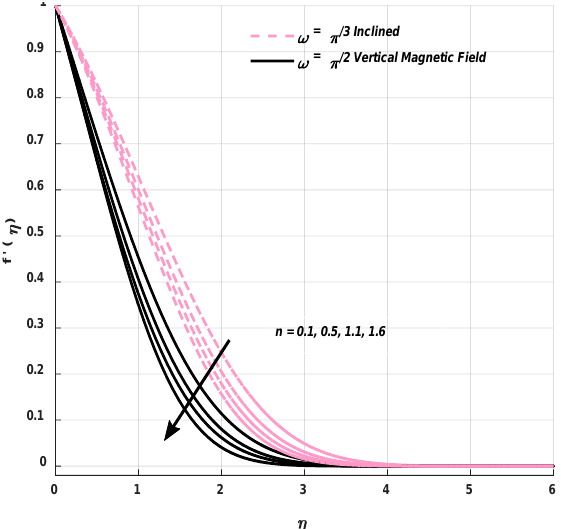
. . . ′ ′ ′ 𝑓𝑓 (𝛾𝛾) 𝑓𝑓 (𝛾𝛾) 𝑓𝑓 (𝛾𝛾)